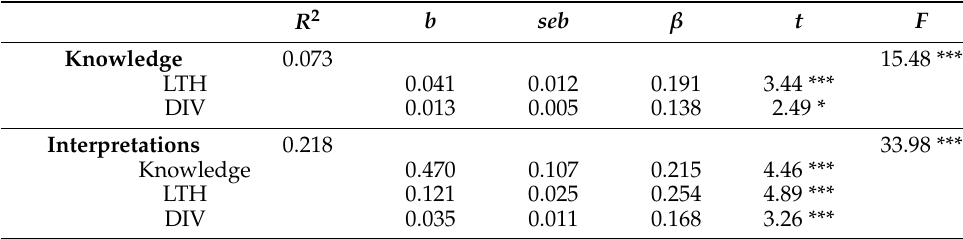
Table 2. Linear regression analysis.